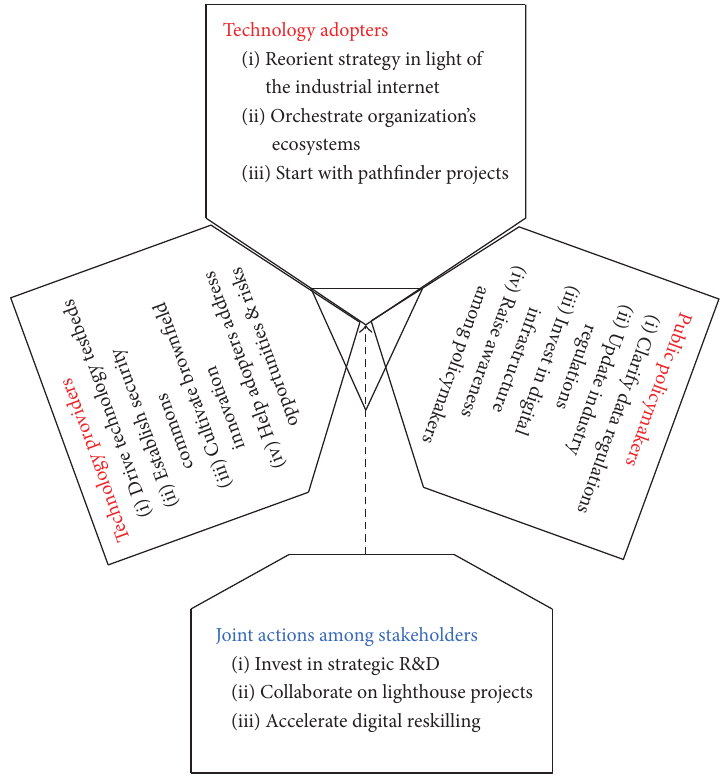
Figure 5: Key recommendations for the three stake holders of Industrial IoT